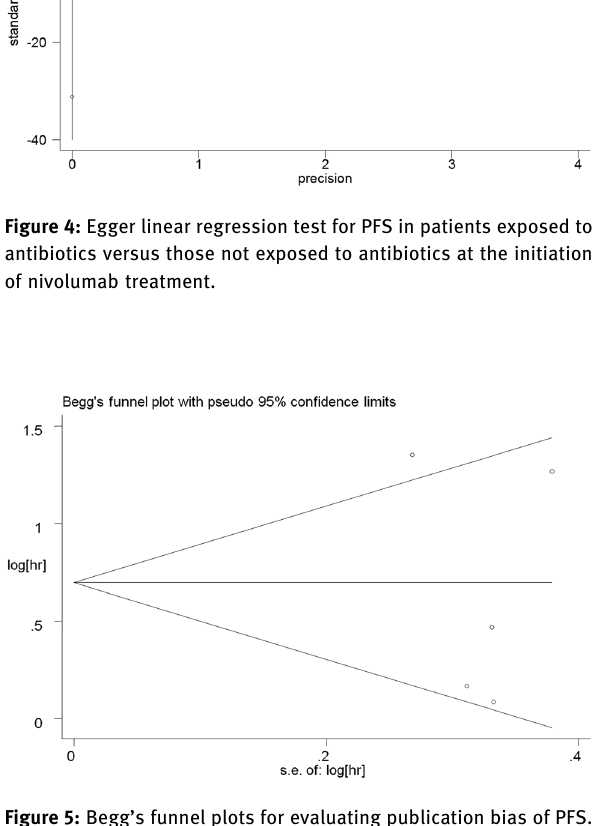
Figure 5: Begg ’ s funnel plots for evaluating publication bias of PFS.